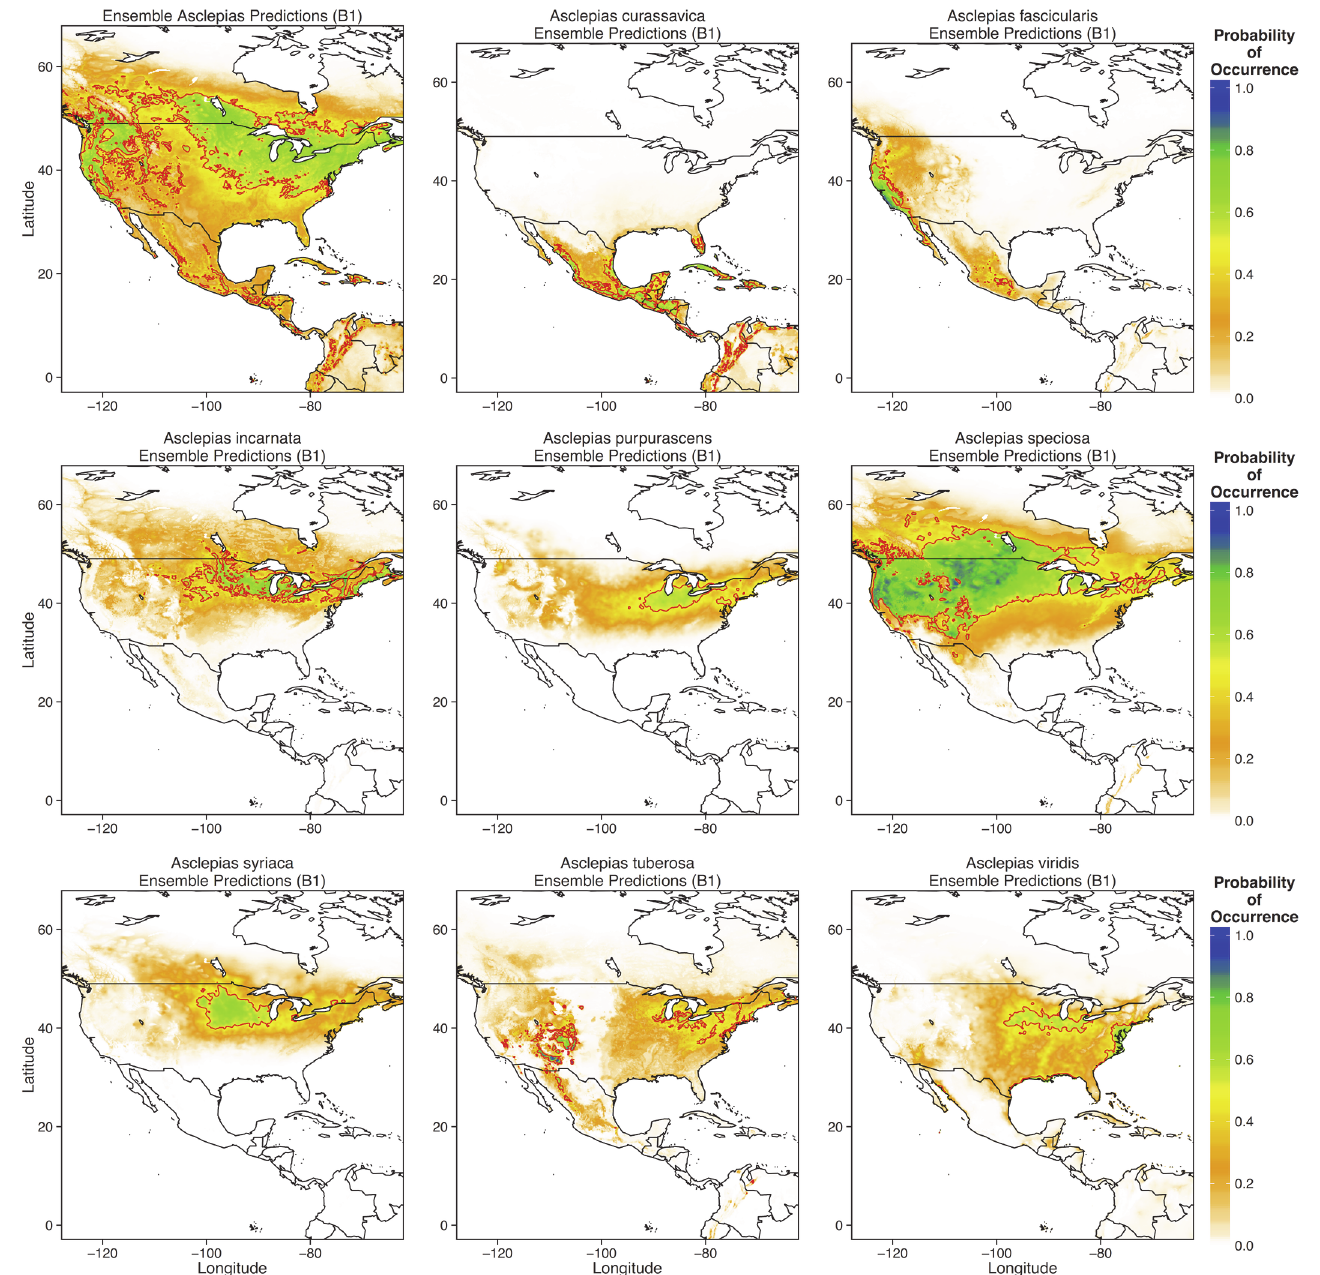
Fig 4. Ensemble predictions of overall Asclepias distribution and each species for all four GCMs under the moderate climate change scenario (B1). Ensemble predictions were created by averaging model output from all four GCM predictions. The thick red line denotes the 0.5 probability contour, such that areas inside the contour have a (cid:1) 0.5 probability of containing Asclepias or the individual